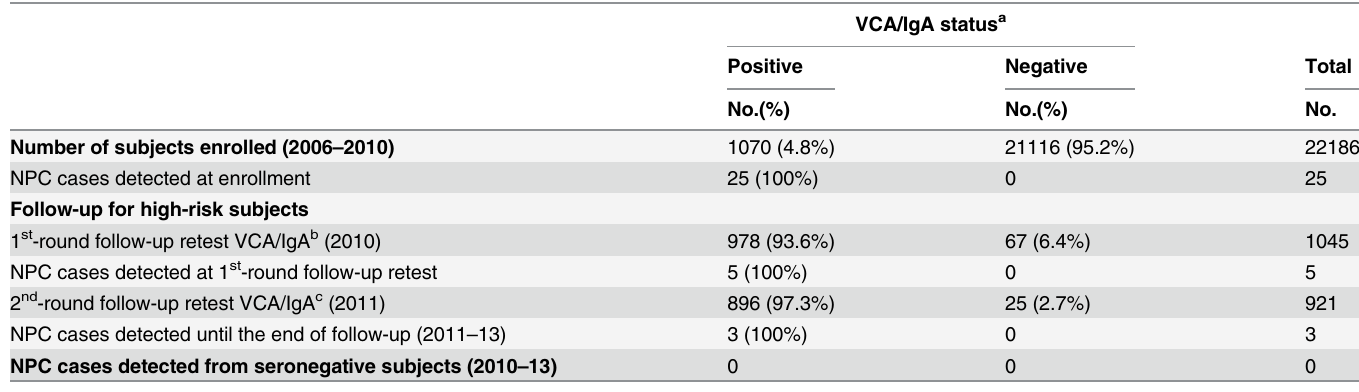
Table 1. Results of a nasopharyngeal carcinoma screening program performed in Cangwu, a high-risk area in